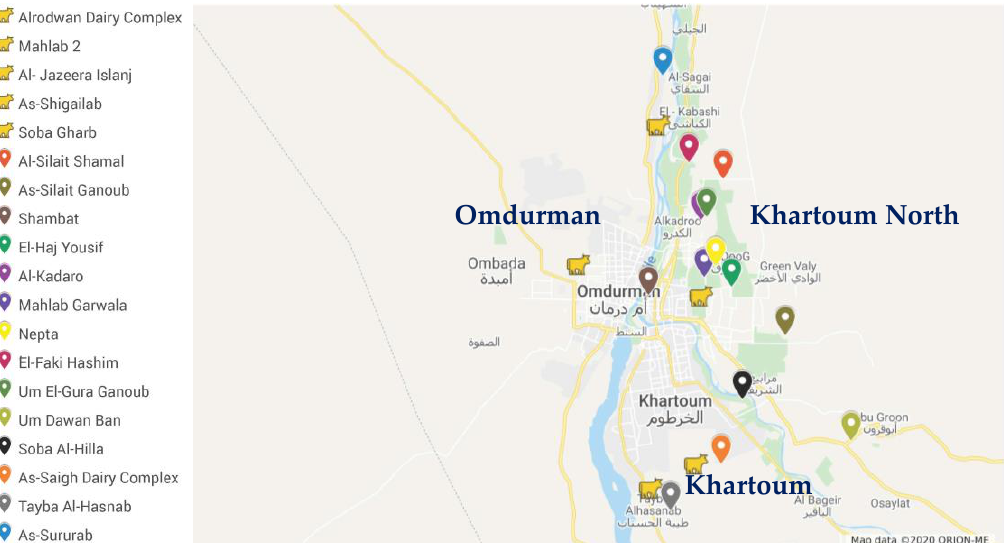
Figure 1. Locations (N = 19) of 37 dairy farms sampled for the seroprevalence of Mycobacterium avium subsp. paratuberculosis (MAP) in Khartoum State. Locations with the cow symbol are those with MAP +ve herds. The map was created from Google Maps® using Google’s account of Kamal H. Eltom